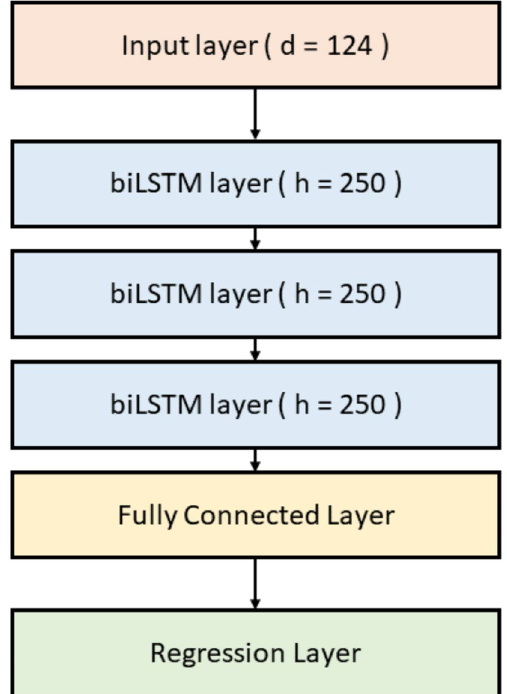
Figure 7. Architecture of the biLSTM used to attempt to recover heard music from our fMRI-informed EEG source